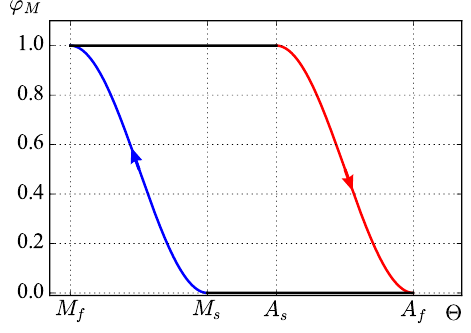
Figure 1. Phase transition